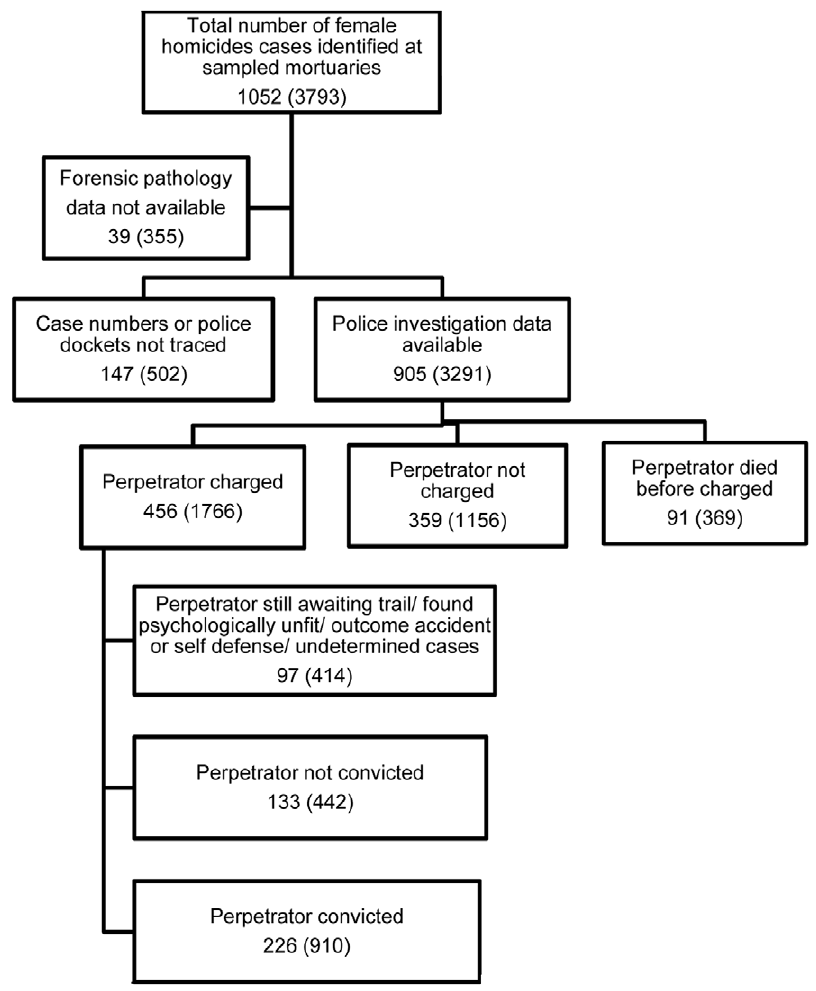
Figure 1. Flow diagram of the charged and convicted female homicide cases (weighted figures in brackets).